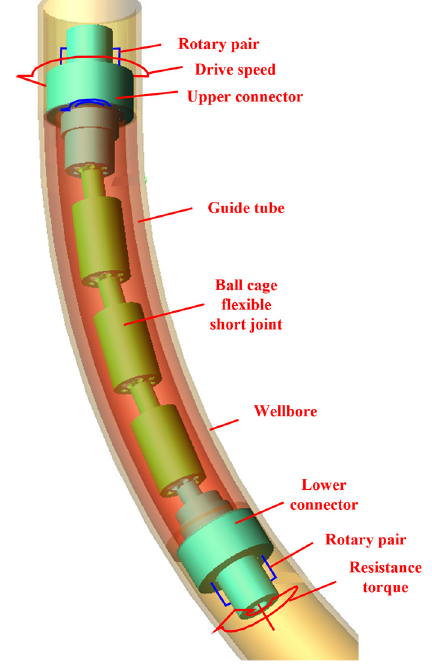
Figure 16. Multi-body dynamics model of flexible drilling tool.